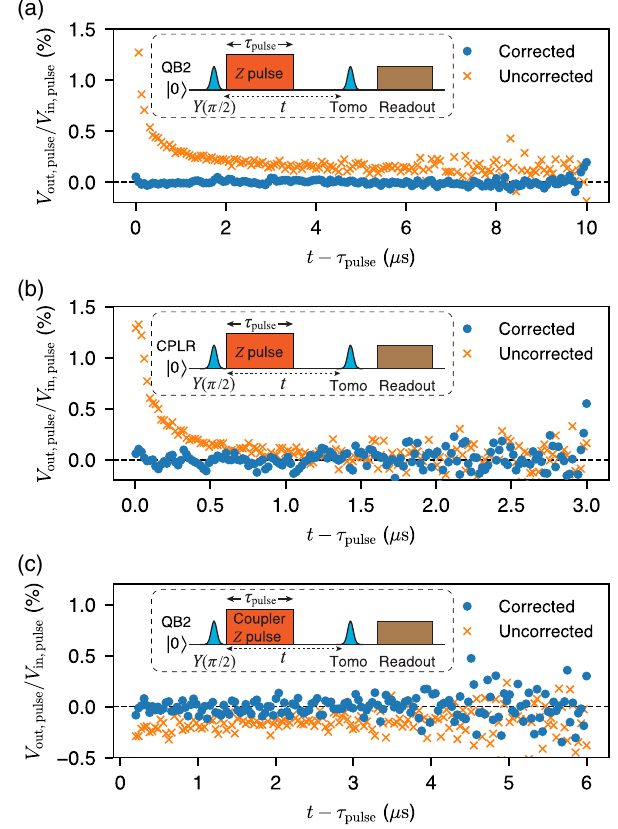
FIG. 15. (a) Measurement of a turn-off transient of a 5 - μ s-long 5 μ s)withoutpredistortion(orangecrosses)and QB 2 Z pulse( τ pulse ¼ withpredistortion(bluecircles).(b)Measurementofaturn-offtransient 1 μ s). (c) Measurement of a for a 1 - μ s-long CPLR Z pulse ( τ pulse ¼ turn-off transient of flux cross talk from the CPLR ’ s flux line to QB2 ’ s 3 μ s) is applied. The SQUID. A 3 - μ s-long CPLR Z pulse ( τ pulse ¼ pulse sequences are illustrated in the insets.